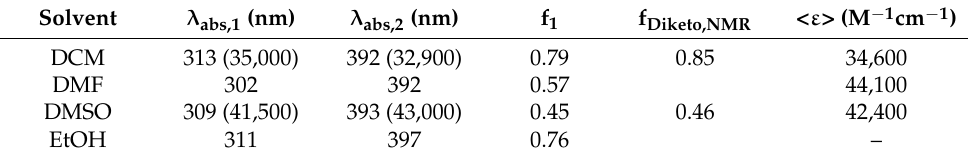
Table 2. UV-Vis absorption properties of 1 in different solvents: peak wavelength of the first absorption band, λ abs,1 , and of the second absorption band, λ abs,2 ; relative intensity of the first absorption peak, f 1 ; fraction of diketo tautomers according to NMR, f Diketo,NMR ; average molar extinction coefficient, < ε > (see text for